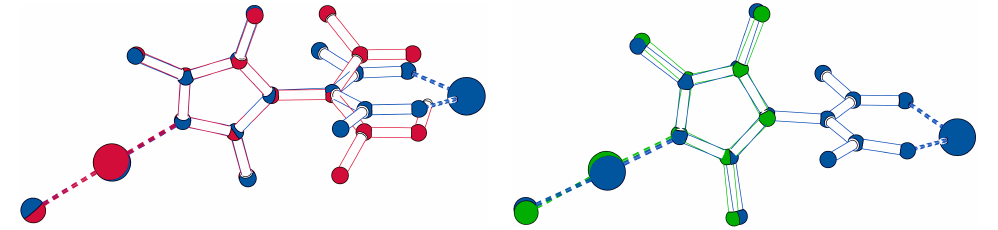
Figure 8. Overlay plots [33] of 3 (blue) with 2 (red) and with XACQUQ